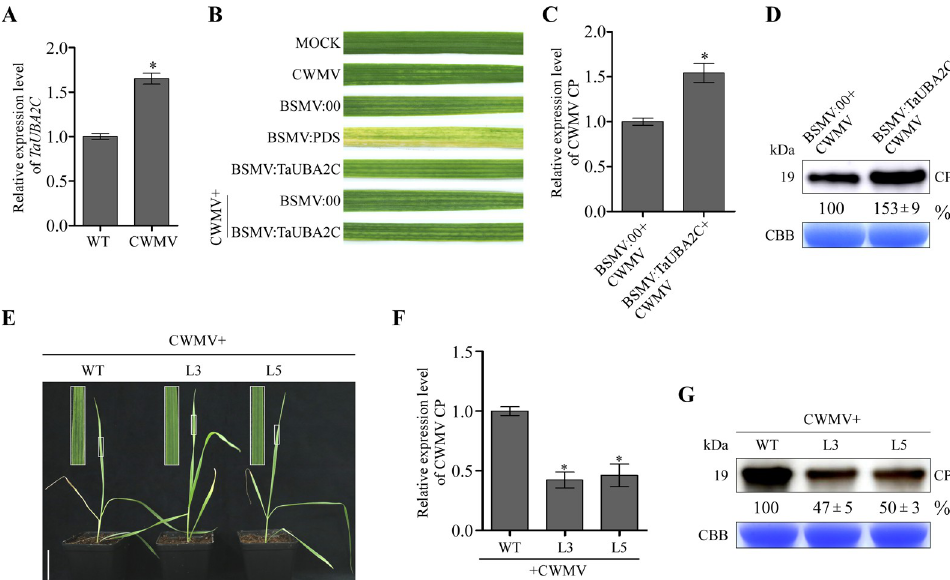
Fig 6. TaUBA2C can facilitate CWMV infection. A. Analysis of TaUBA2C expression in the mock- or the CWMV- inoculated wheat plants through qRT-PCR. The data presented are the means ± SD, determined using the Student’s t - test. Each treatment had three biological replicates. � , P < 0.05. B. Mosaic symptoms in the wheat leaves infected with CWMV, BSMV:00, BSMV:PDS, BSMV:TaUBA2C, BSMV:00+CWMV or BSMV:TaUBA2C+CWMV. Mock indicates that the leaf was from a plant inoculated with the FES buffer. Photographs were taken at 21 dpi. C. Quantitative RT-PCR analysis of CWMV CP accumulation in the BSMV:00+CWMV- or BSMV:TaUBA2C+CWMV-inoculated wheat plants at 21 dpi. The data presented are the means ± SD, determined using the Student’s t -test. Each treatment had three biological replicates. � , P < 0.05. D. Detection of CWMV CP in the assayed wheat plants through western blot analysis using a CWMV CP specific antibody. The data presented are the means ± SD. Each treatment had three biological replicates. The CBB-stained gel is used to show sample loadings. E. Disease symptoms on the CWMV-inoculated wild type (WT) or the two TaUBA2C overexpression transgenic lines (L3 and L5). Photographs were taken at 21 days post CWMV inoculated. Scale bar = 5 cm. F. Detection of CWMV CP accumulation in the CWMV-inoculated WT, L3, and L5 plants, respectively, through qRT-PCR at 21 dpi. The data presented are the means ± SD, determined using the Student’s t -test. Each treatment had three biological replicates. � , P < 0.05. G. Detection of CWMV CP accumulation in the assayed plants through western blot analysis using a CWMV CP specific antibody. The data presented are the means ± SD. Each treatment had three biological replicates. CBB-stained gel is used to show sample loadings.